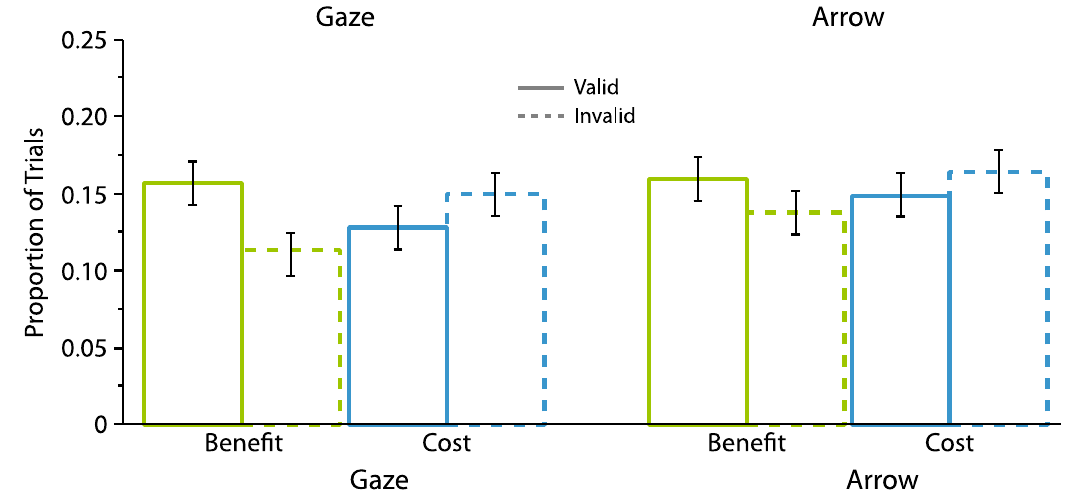
Figure 7. The proportion of benefits and costs as a function of cue type and cue validity for Experiment 2. Error bars represent standard error of the difference between the means.